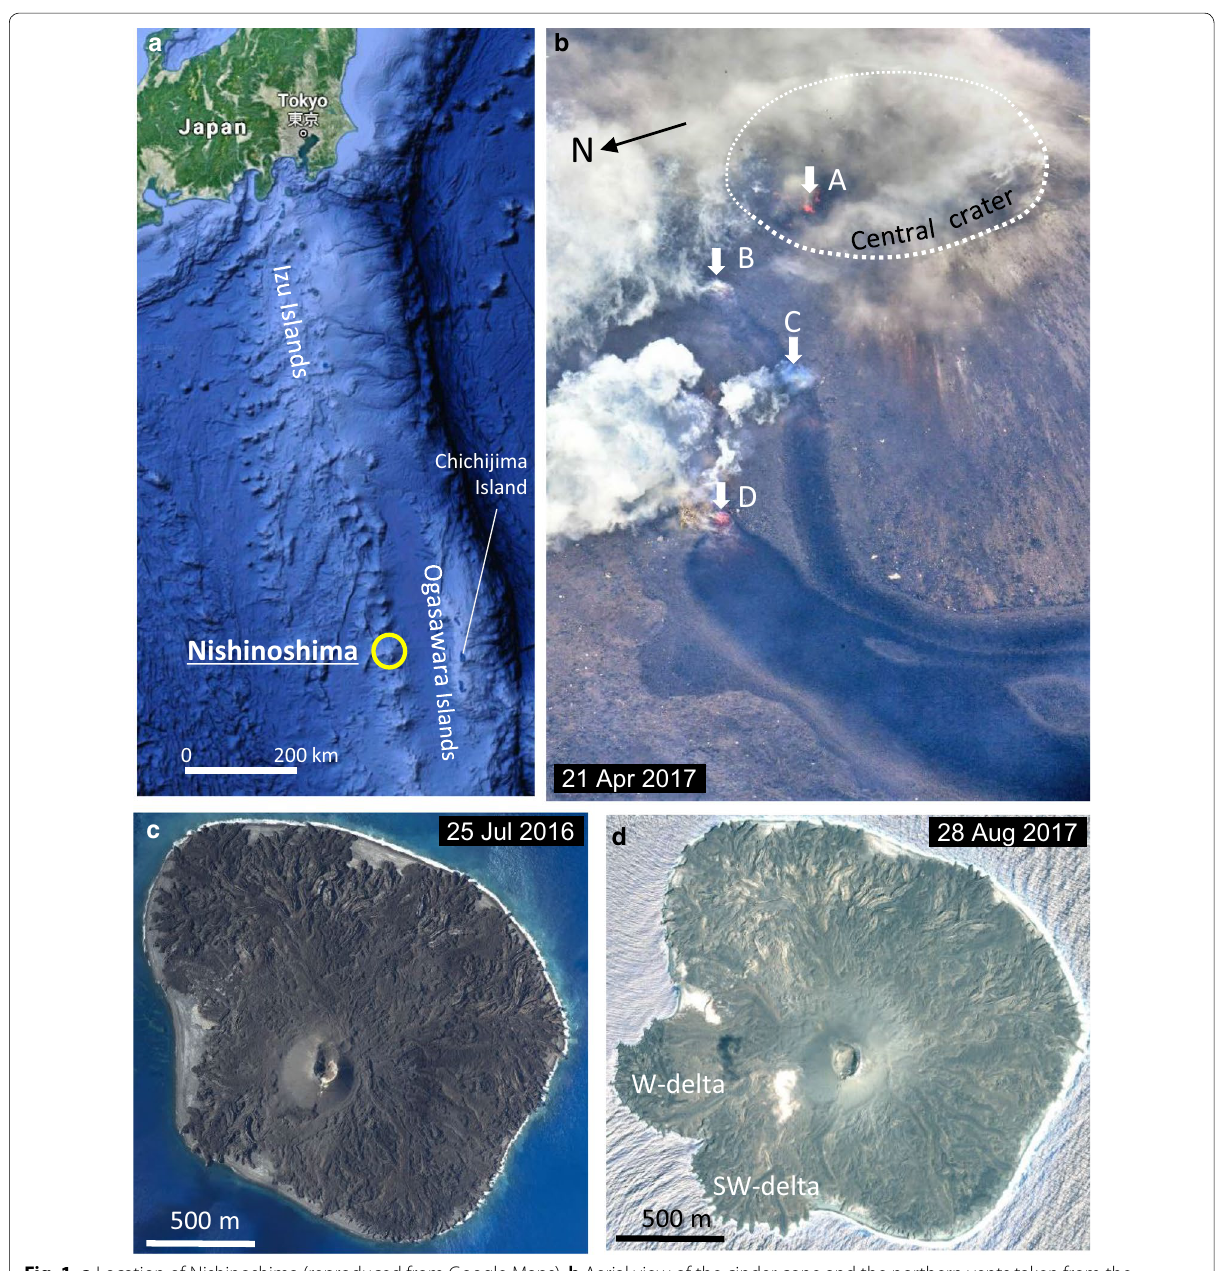
Fig. 1 a Location of Nishinoshima (reproduced from Google Maps). b Aerial view of the cinder cone and the northern vents taken from the northwestern side on 21 April 2017 (provided by Asahi Shimbun). c Nishinoshima after the 2013–2015 eruption (25 July 2016) (Geospatial Information Authority of Japan). d Pleiades image of Nishinoshima after the 2017 eruption (28 August